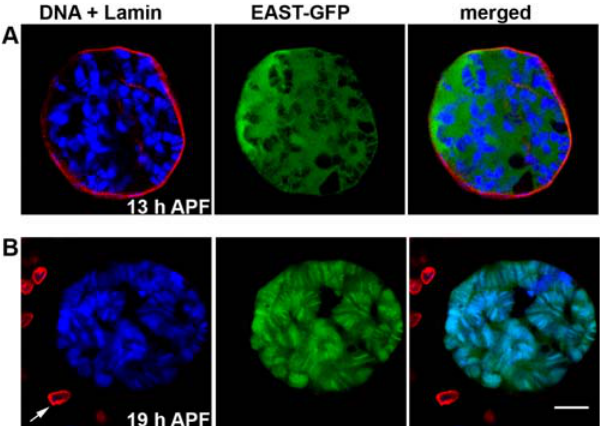
Figure 5. Change of localization of EAST-GFP during apoptosis. (A) In a 13 h APF old pupa, EAST-GFP (green) shows mainly extrachromo- somal localization. The nuclear lamina (red) is still intact. DNA (blue) was labeled with TOPRO-3. (B) Co-localization of EAST-GFP with intact polytene chromosomes can be observed in a 19 hour APF old pupa. The destruction of the lamina indicates that part of the apoptotic program is executed. Note the barely detectable anti-lamin staining in salivary glands compared to neighboring diploid cells (arrow). The Bar in A represents 10 m m and also applies to B.